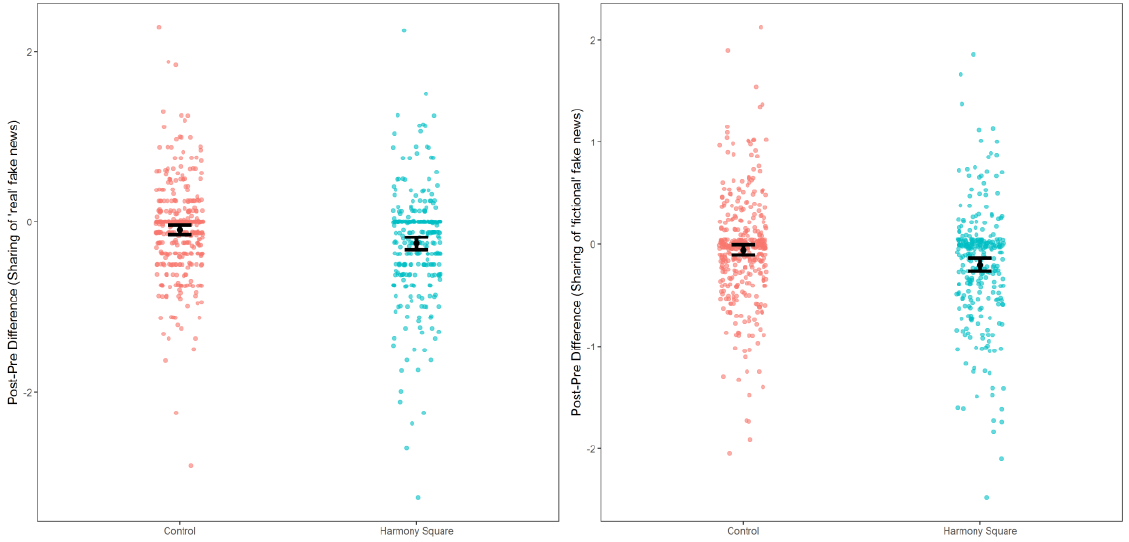
Figure 4. Pre-post d ifference scores for willingness to share for both “real” and “fictional” misinformation, for the treatment and control groups. The black dot in the middle indicates the mean value. Error bars represent 95% confidence intervals. In both plots, the distribution for the Harmony Square group is shifted downwards, indicating that people shared fake news posts significantly less after playing in the treatment group. Separate bars for pre and post scores (by condition) are provided in Supplementary Figure